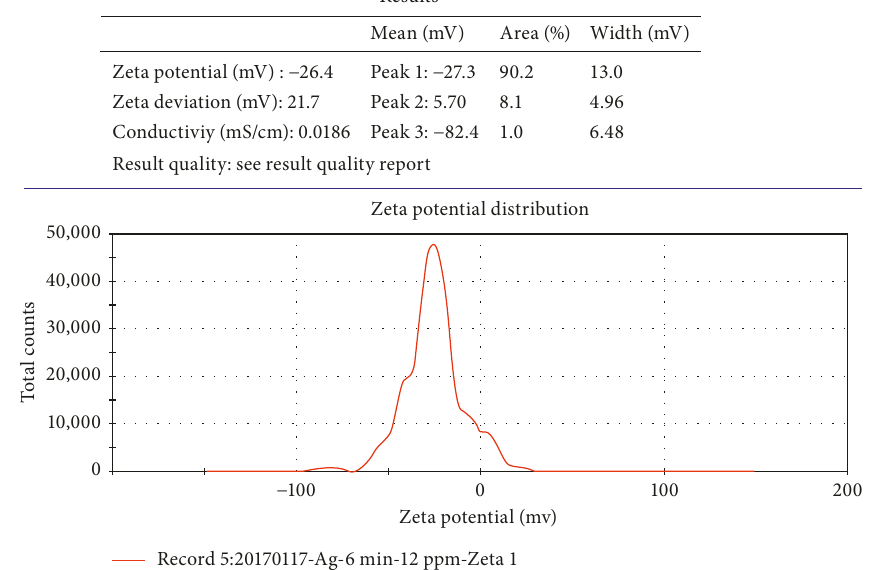
Figure 12: Zeta of aqueous colloid silver ( arcing in DW for 6